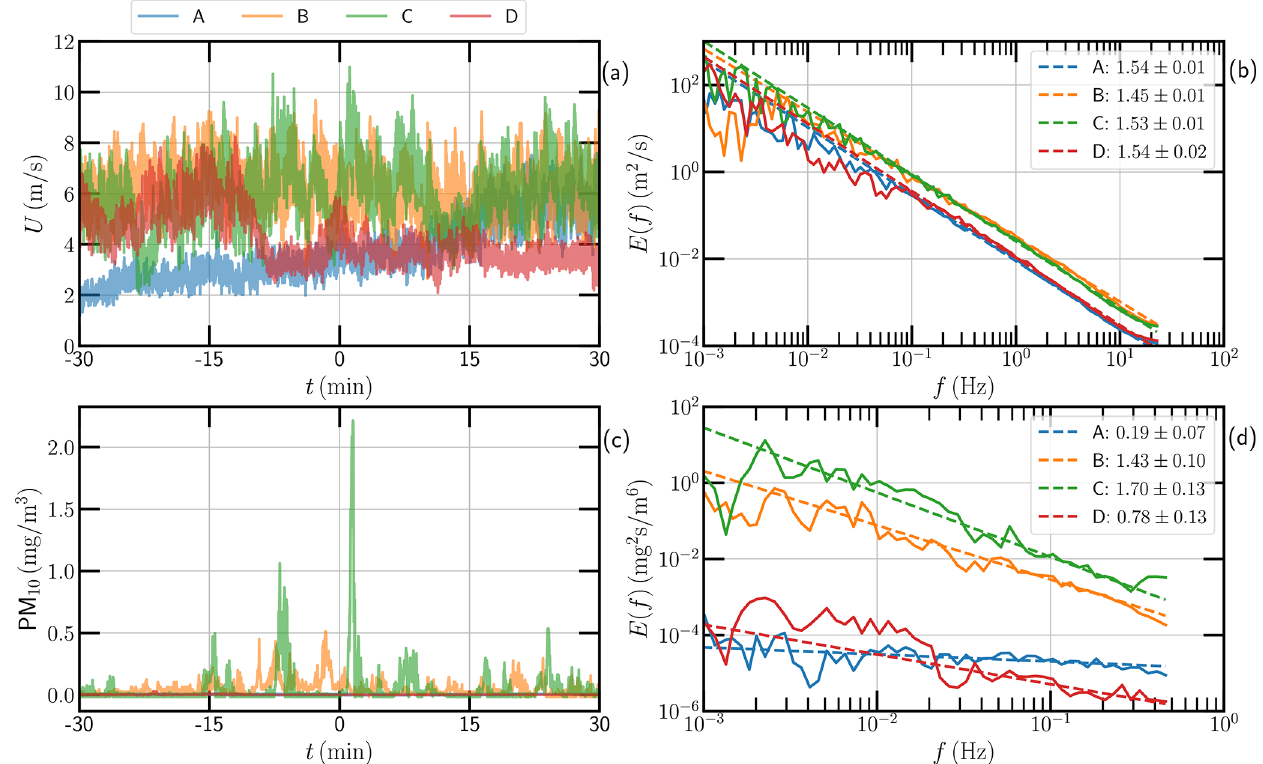
Figure 7. (a) Segment of 1h of the raw wind speed around time A, B, C and D at a height of 3.49m. (b) The corresponding Fourier power spectrum. (c, d) The PM 10 and their Fourier spectra at the same height and time period. The dashed line is the power-law fit for reference.